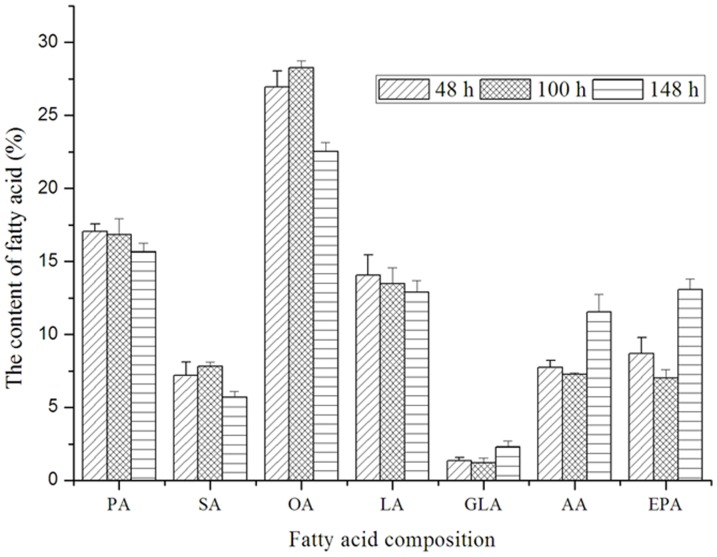
The fatty acid composition of P. splendens at different fermentation stages.PA: palmitic acid, SA: stearic acid, OA: oleic acid, LA: linoleic acid, GLA: γ-linolenic acid, AA: arachidonic acid, EPA: eicosapentaenoic acid.